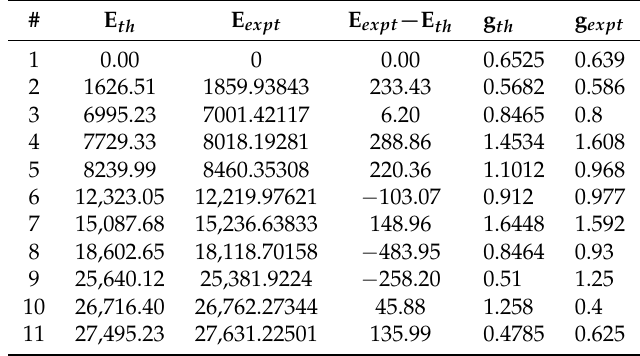
Table 4. Energies (cm − 1 ) and g-factors for optimized parameters presented in Table 1 for J = 1.5 even states. The experimental energies and g-factors are taken from NIST database